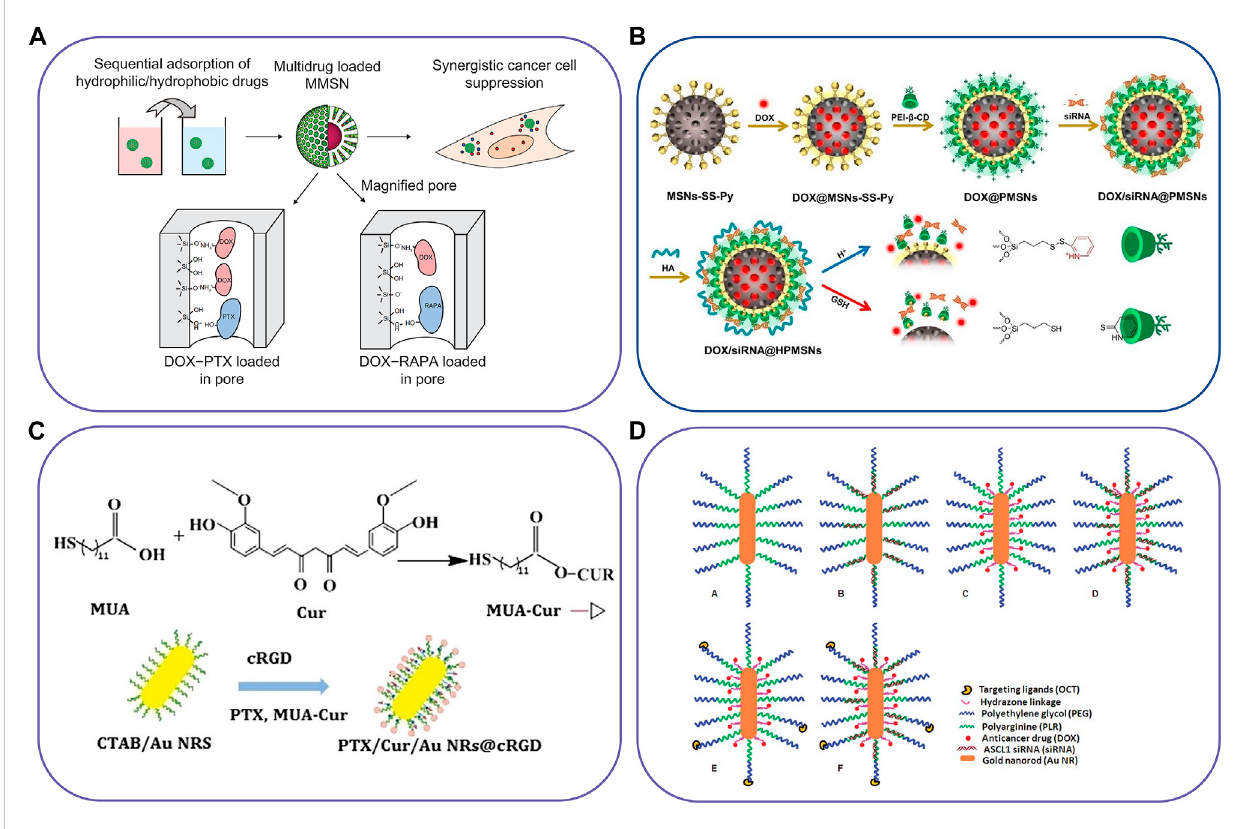
FIGURE 4 Schematicillustrationofinorganic-basednanocarrierstoco-delivertwodifferentagents. (A) The magneticmesoporoussilicananoparticlesforco- deliver of DTX and PTX/RAPA, (B) pH/redox dual-responsive nanosystem to delivery DOX and siRNA, (C) Gold nanorod vesicles for co-delivery of CUR and PTX, and (D) Octreotide-conjugated gold nanorods for co-delivery of DOX and siRNA. Reproduced with permission from ref. (Liu et al., 2012), (Yuan et al., 2021), (Zhu et al., 2019), (Xiao et al., 2012). Copyright 2012, 2021, 2019 and 2012, Dovepress, Elsevier, BioMed Central, and Royal Society of Chemistry,